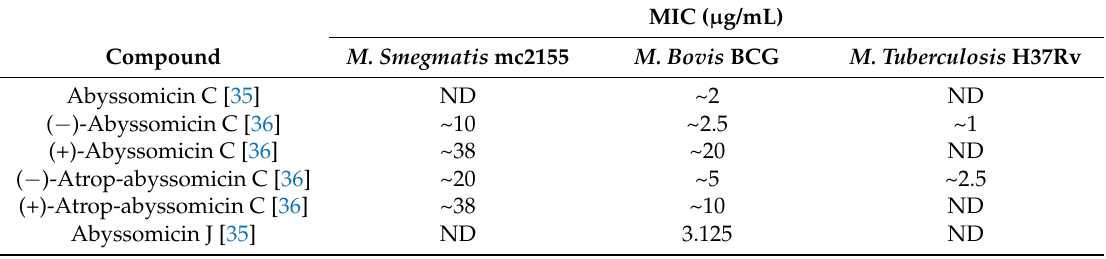
Table 2. MICs ( µ g/mL) of active abyssomicins and derivatives against different mycobacteria strains.